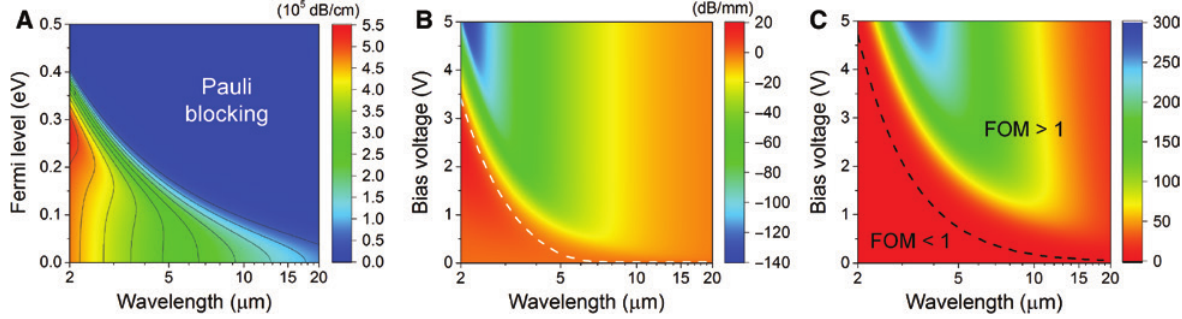
Figure 12: Performance projection for mid-IR graphene electroabsorption modulators. (A) Contour plot showing the Fermi-level-dependent optical absorption of a graphene monolayer across the mid-IR band calculated using the surface conductive model; (B) simulated modulation depth of graphene mid-IR electroabsorption modulators, the white dashed line corresponds to zero modulation depth; (C) FOM (modulation depth/insertion loss) of the modulator: the black dashed line corresponds to unity